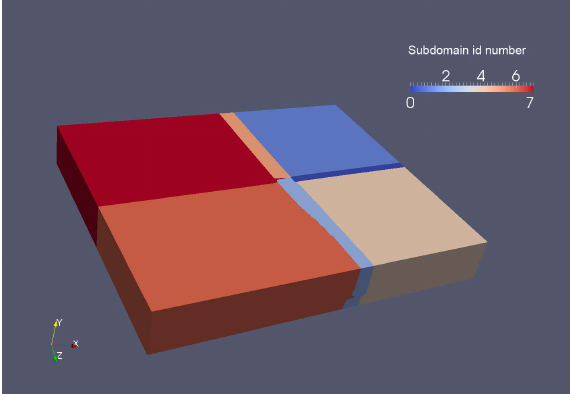
Figure 3. Computational domain divided in eight subdomains in order to accelerate the simulation.